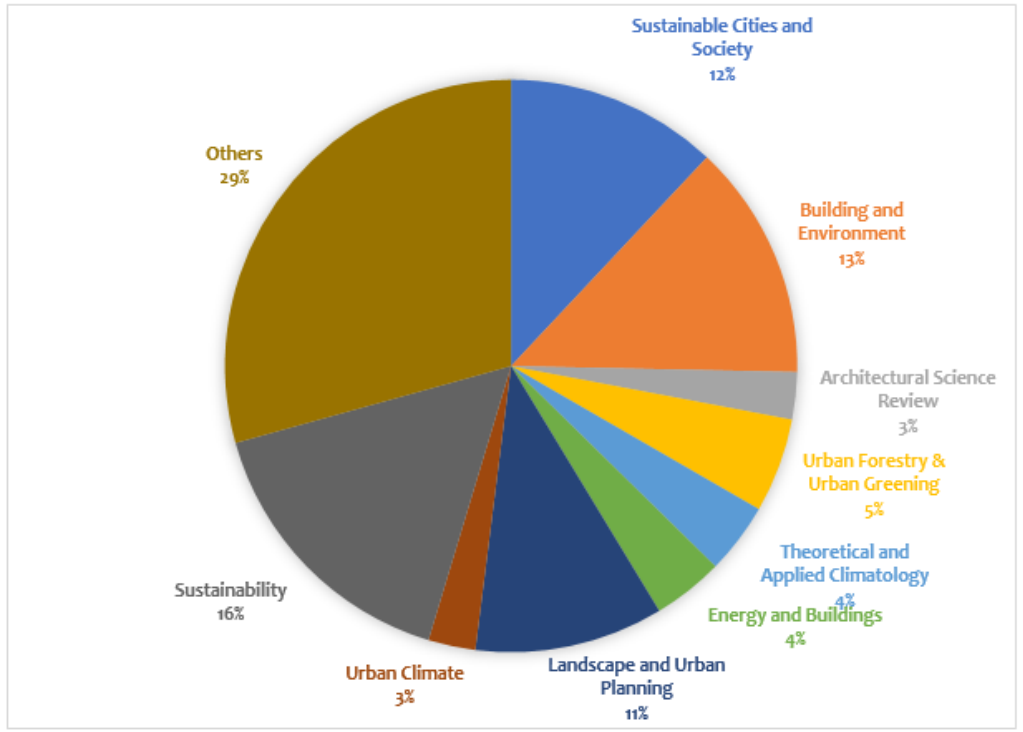
Figure 1. The main journals where the reviewed papers were published.